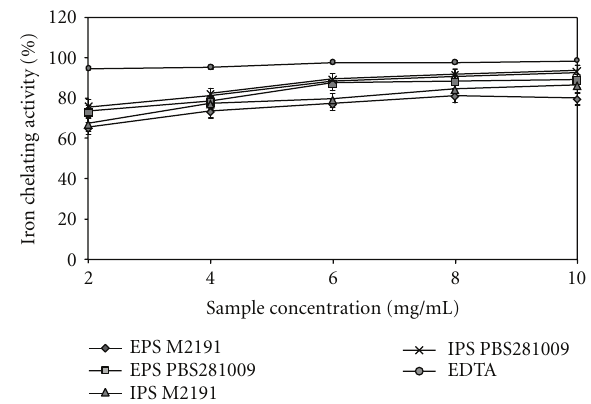
Figure 5: Reducing power of EPS and IPS from submerged culture of Pleurotus ostreatus M2191 and PBS281009. Figure 6: Ferrous ion-chelating ability of EPS and IPS from submerged culture of Pleurotus ostreatus M2191 and